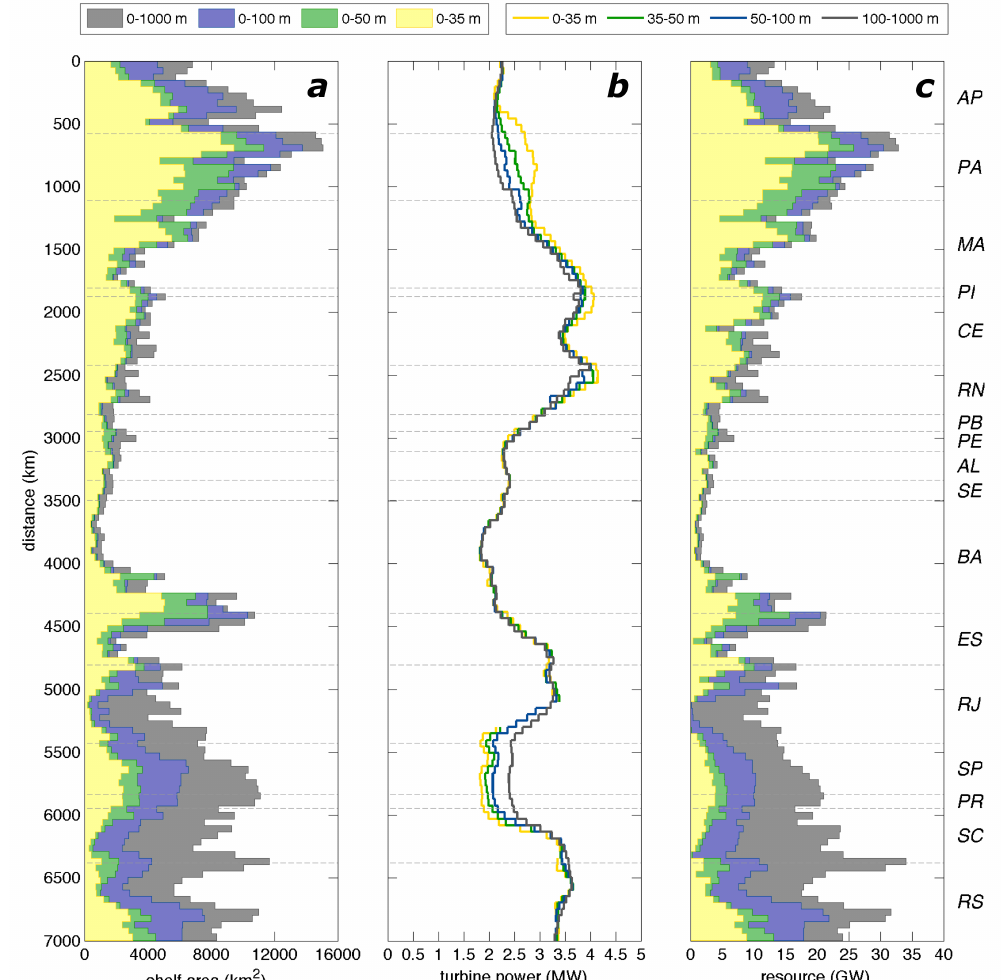
Figure 10. ( a ) Shelf area, ( b ) turbine mean power P c and ( c ) resource distribution R . Here the y-axis represents the distance (km) along the Brazilian coast, from its northern limit at Amapá (AP, top) to its southern end at Rio Grande do Sul (RS, bottom). Shelf area (km 2 ) is computed from ETOPO1 data using the section divisions of Figure 1. Filled curves correspond to depths intervals that vary from 0–35 m (yellow) to 0–1000 m (gray). Turbine average power P c is computed for the depth intervals: 0–35 m, 35–50, 50–100 and 100–1000 m. Wind resource (GW) is estimated from P c for the same depth intervals used in the area computation (panel a). Estimates are based on the SE 6.2 power curve, considering Monin–Obukhov vertical extrapolation and the density correction of Equation (10). Coastal states’ divisions are depicted by horizontal dashed lines and their labels are placed on the